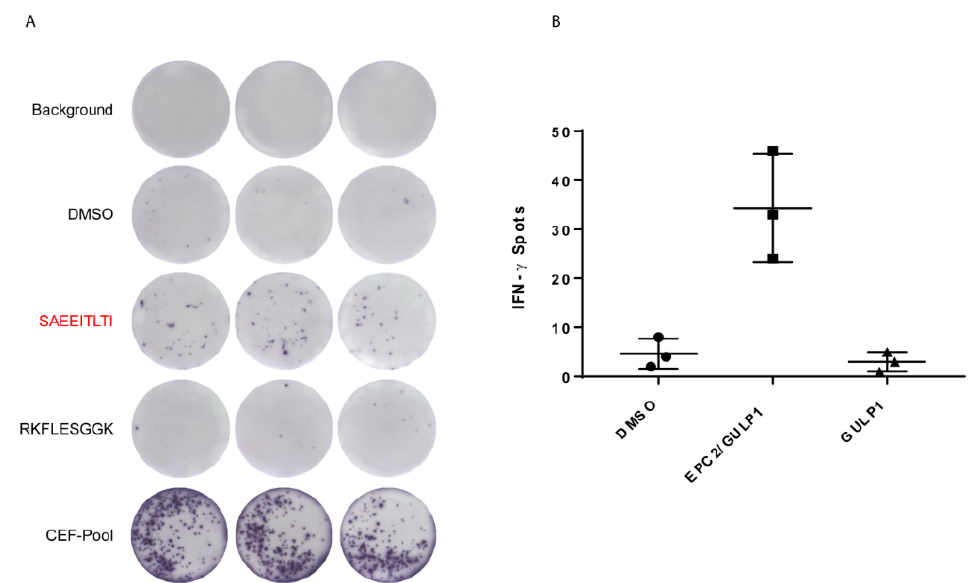
Figure 4. CD8 + T cells are reactive towards fusion peptide. ( A ) ELISpot analysis after in vitro assay based on co-culturing peptide loaded DCs with CD8 + T cells of healthy donor no. 1. DMSO was taken as vehicle control, wildtype peptide of GULP1 as negative control and CEF-pool as positive control. The fusion peptide is marked red. Quantification of the spots is shown in ( B ). Mean values and standard abbrevation of IFN- γ spots after stimulation with the fusion peptide and wildtype peptide. DMSO treated cells were used as negative control.